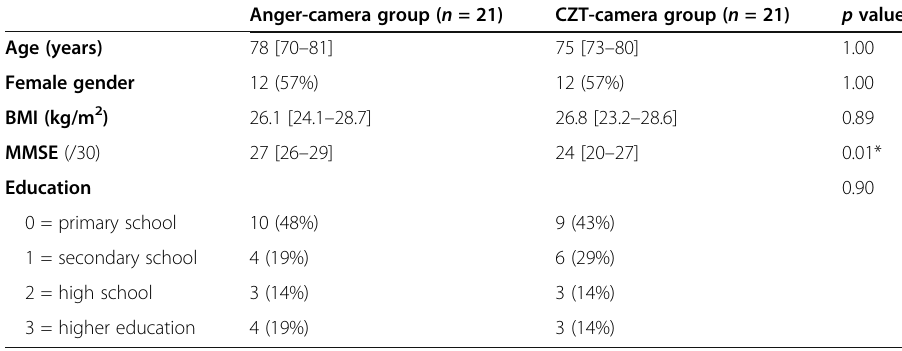
Table 1 Main patient characteristics in the 2 groups of patients imaged with the Anger or CZT cameras